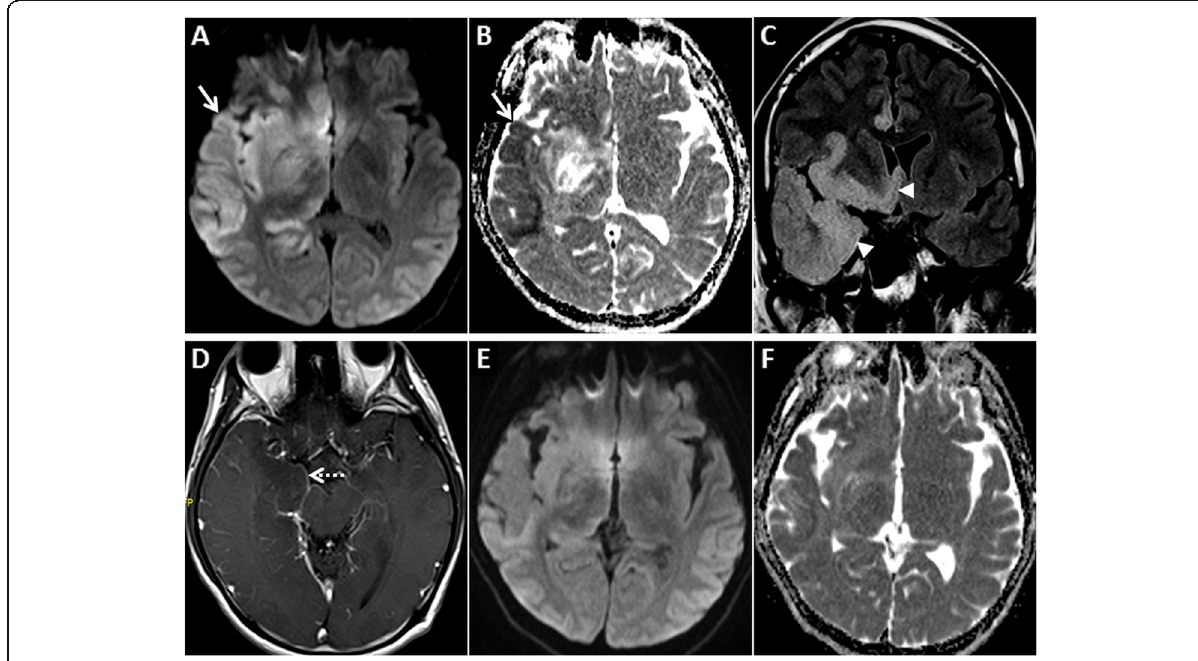
Fig. 8 Pre- and post-contrast enhanced MRI of the brain in a 36-year-old male patient with HSVE. GRD is noted in the right temporal lobe (arrow) on axial DWI ( a ) and ADC image ( b ). Also note DWI hyperintensity in the right insula and cingulate gyrus ( a , b ). Coronal FLAIR image ( c ) reveals hyperintense signal and cortical swelling in the right inferior frontal and mesiotemporal regions (arrowheads). Post-contrast axial T1W image ( d ) shows smooth leptomeningeal enhancement over the right temporal cortices (dashed arrow). Post-treatment follow-up MRI shows significant resolution of previously seen GRD and cortical swelling on axial DWI ( e ) and ADC image ( f